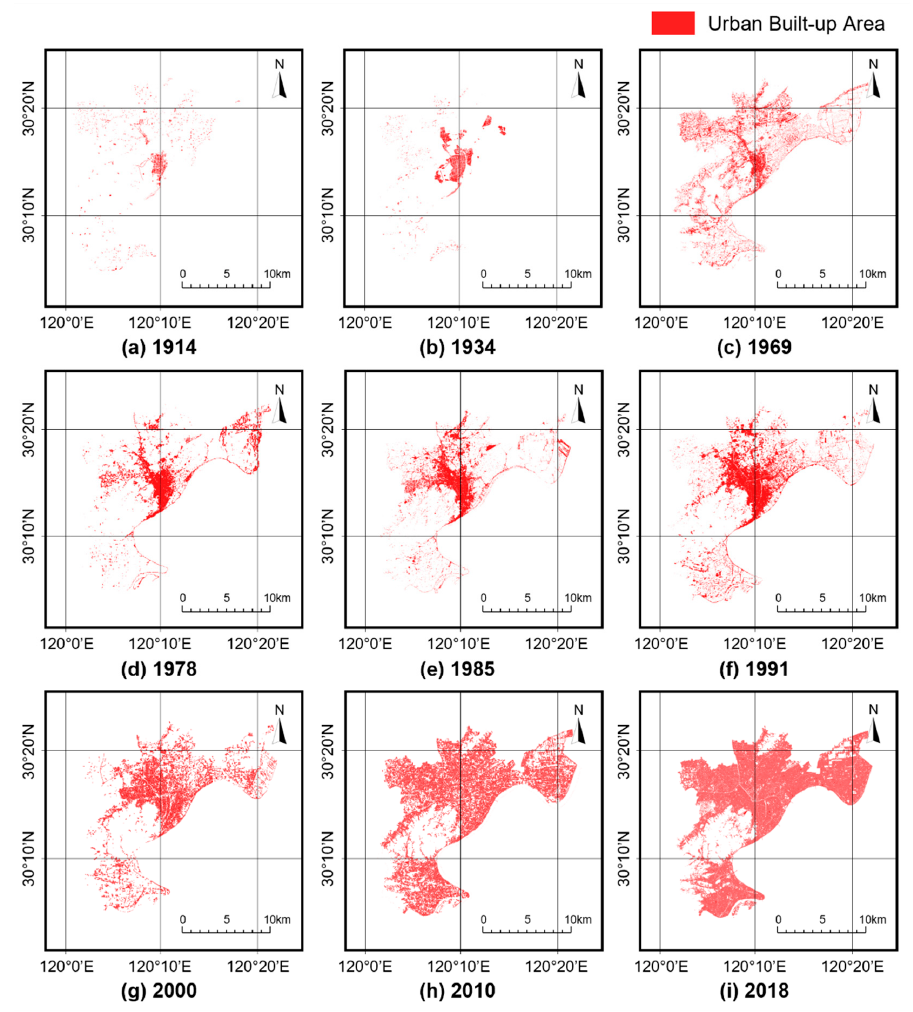
Figure 2. Urban built-up area in Hangzhou from 1914 to 2018.